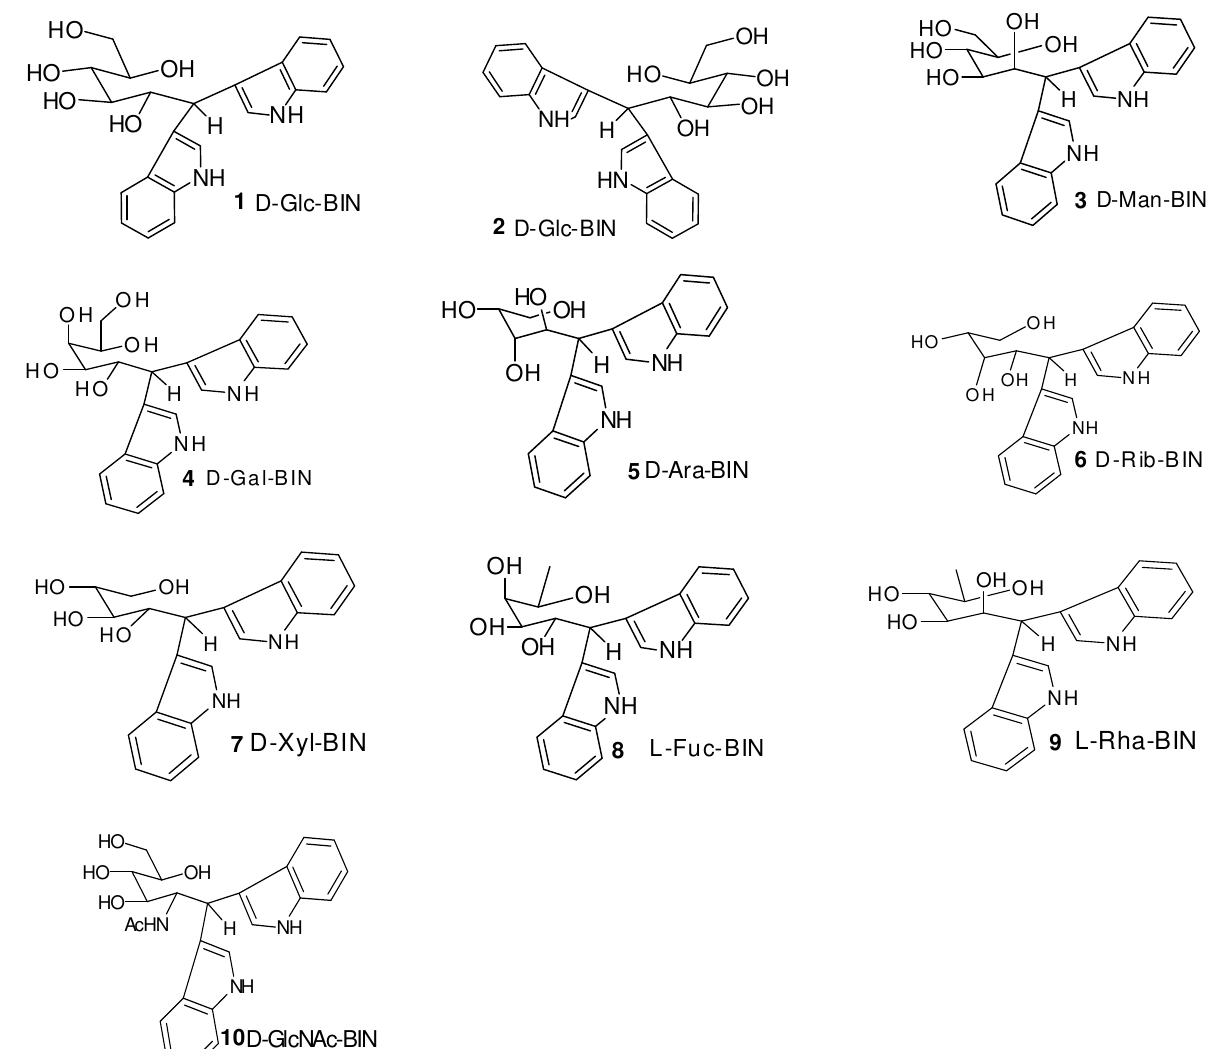
Figure 5. The chemical structures of D -, L